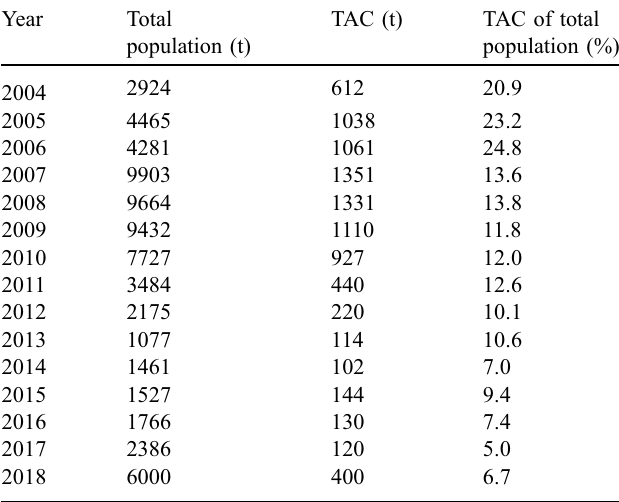
Table 1. Total fl at population data (tons) from 2004 to 2018 and total allowable catch (TAC) in tons and as percentage of total